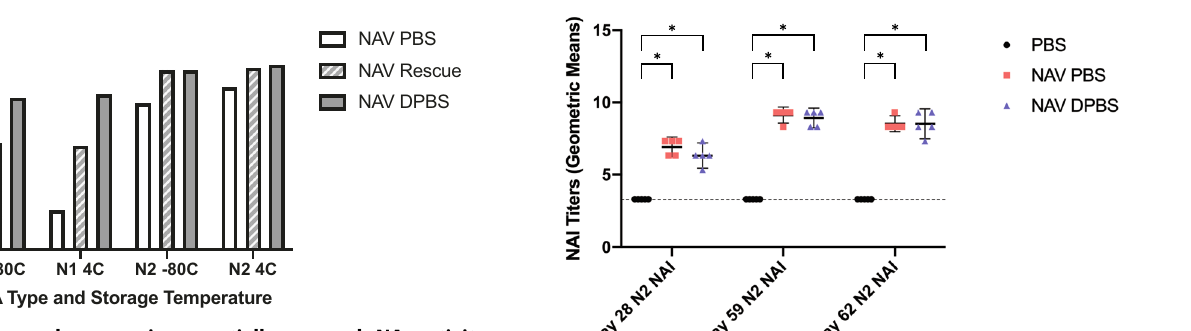
Fig. 4 Calcium and magnesium partially rescued NA activity in vitro of N1 and N2 stored at − 80 °C or 4 °C in PBS. N1 and N2 stored at − 80 °C or 4 °C in PBS or DPBS for 36 weeks. PBS samples were rescued with DPBS and log 2 -transformed NA activities of NAV PBS, NAV rescue, and NAV DPBS samples were compared. Bars represent individual samples.